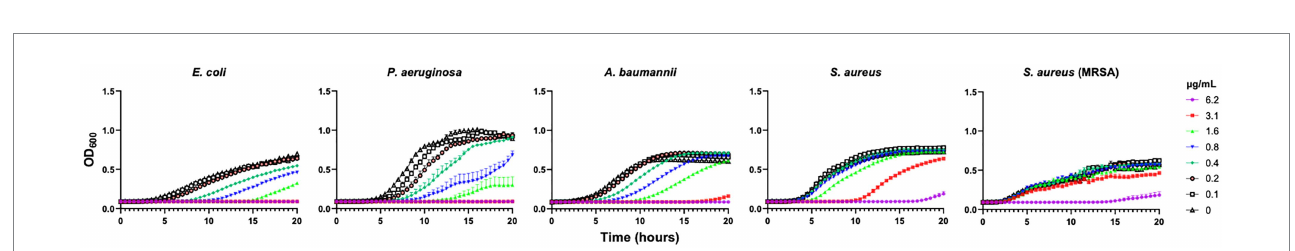
FIGURE 2 AgNPs broadly inhibit the growth of bacteria. Growth of E. coli DH5 α , P. aeruginosa PAO1, A. baumannii 17978, S. aureus 12600 and S. aureus MRSA 131 after incubation with 0–6.2 μ g/mL AgNP Formula 1.1 was assessed by measuring OD 600 for 20 h at 37 ° C. Each growth curve is an average of three independent experiments with three internal replicates per run. Error bars represent